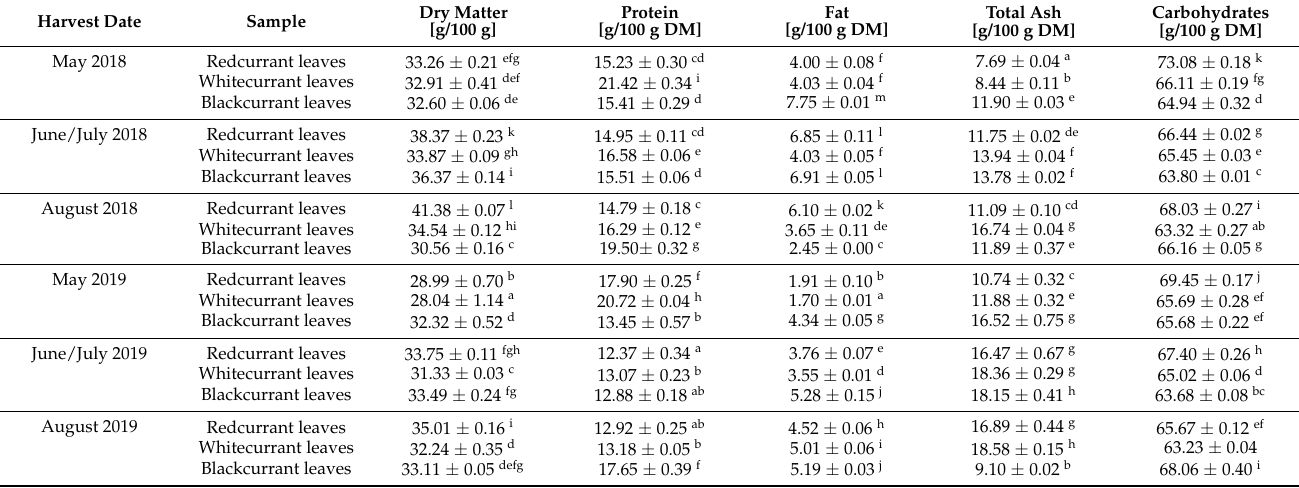
Table 1. Basic composition of the leaves of three currant species harvested at different dates in 2018 and 2019. Harvest Date